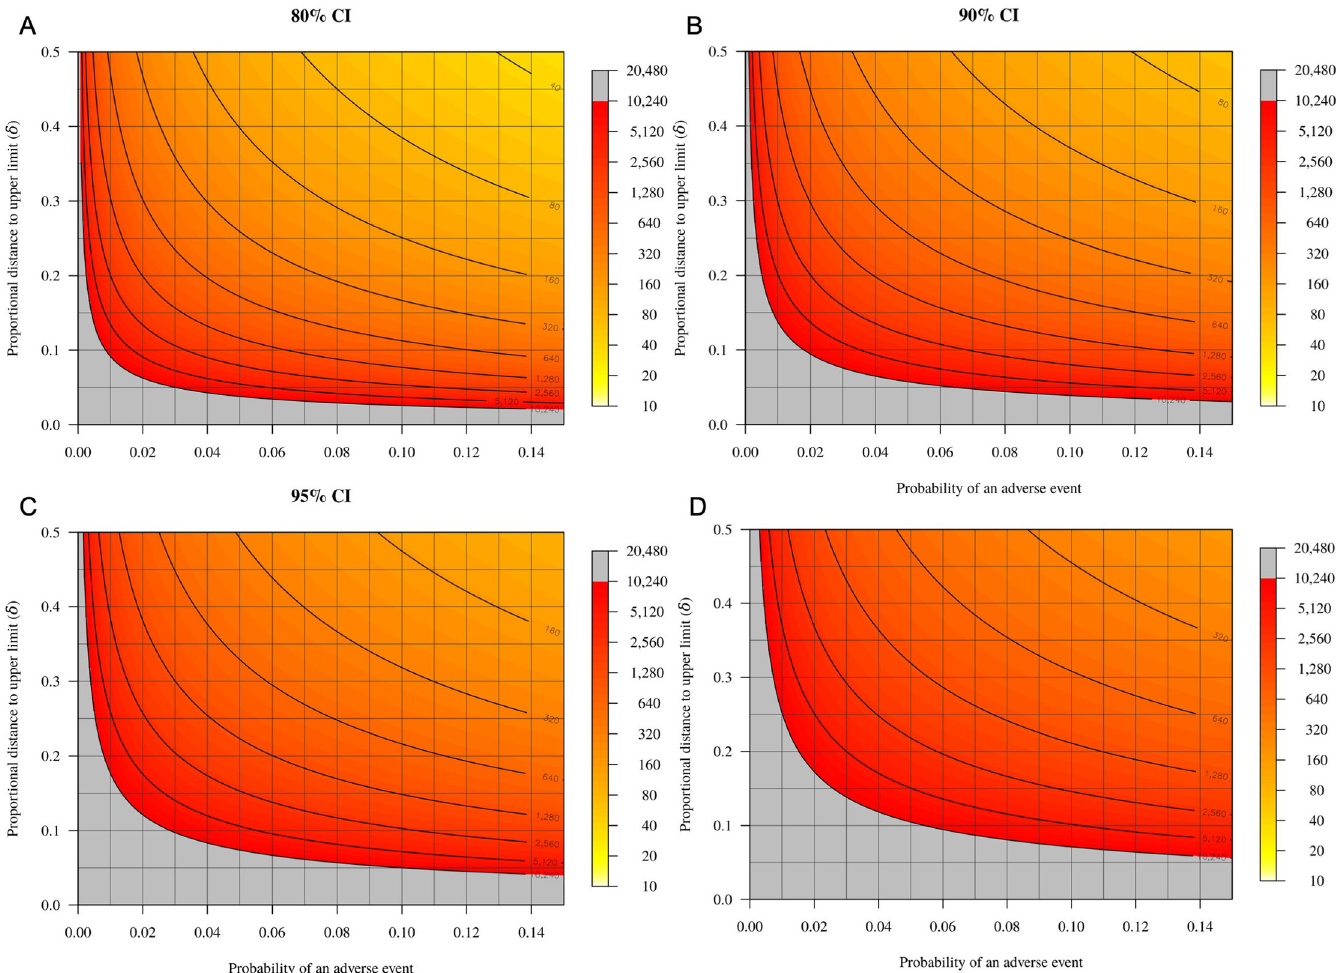
Fig 2. Heat maps illustrating the relationship between the probability of an adverse event ( x -axis), proportional distance to desired upper limit ( δ ; y -axis) and required sample size (yellow-grey gradient) for different required confidence levels (80–99%; a–d).